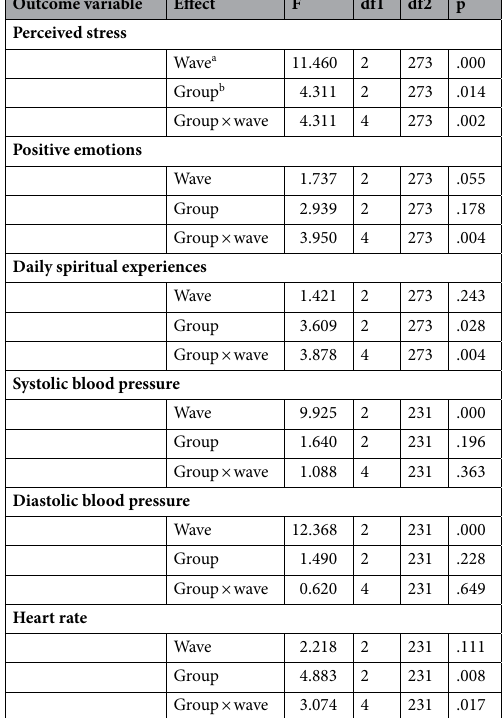
Table 5. Repeated measures analysis using generalized linear mixed model for the six outcome variables with controls for gender, age, ethnicity/race, religious preference, and baseline exercise. a Wave was baseline, 12 weeks after baseline, and 18 weeks after baseline. b Group was Tamarkoz treatment, stress management control, or Tamarkoz waitlist